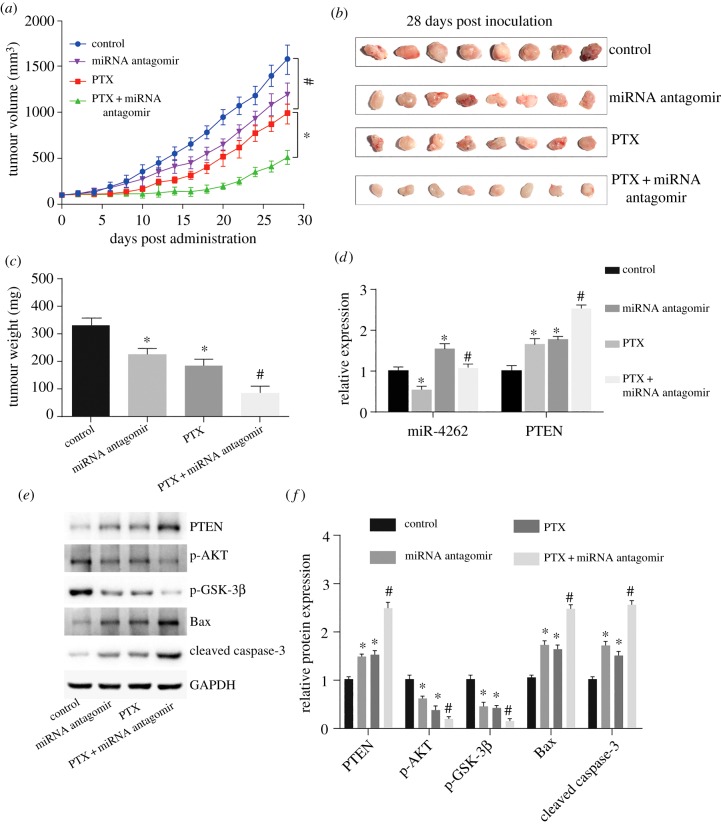
The inhibition of miR-4262 induces chemosensitivity to PTX in vivo. A549/PTX cells were subcutaneously injected into nude mice to form xenografts. At 7 days after injection, 0.1 ml PBS, miR-4262 antagomir, PTX or PTX + miR-4262 antagomir was administered intravenously to the xenograft mice (once every 3 days) for 24 days. (a) The tumour volume was measured every other day after the first injection. ***p < 0.001, ###p < 0.001. (b) Representative tumours in each group are shown. (c) The tumour weight was analysed at 30 days after the first injection. (d) qRT-PCR assays were used to analyse the expression levels of miR-4262 and the mRNA expression levels of PTEN in excised tumours from the mice. (e,f) Western blot assays were used to analyse the protein expression of PTEN, p-Akt, p-GSK-3β, Bax and cleaved caspase3 in excised tumour tissues. *p < 0.05 versus the control group; and #p < 0.05 versus the PTX group or miRNA antagomir group.